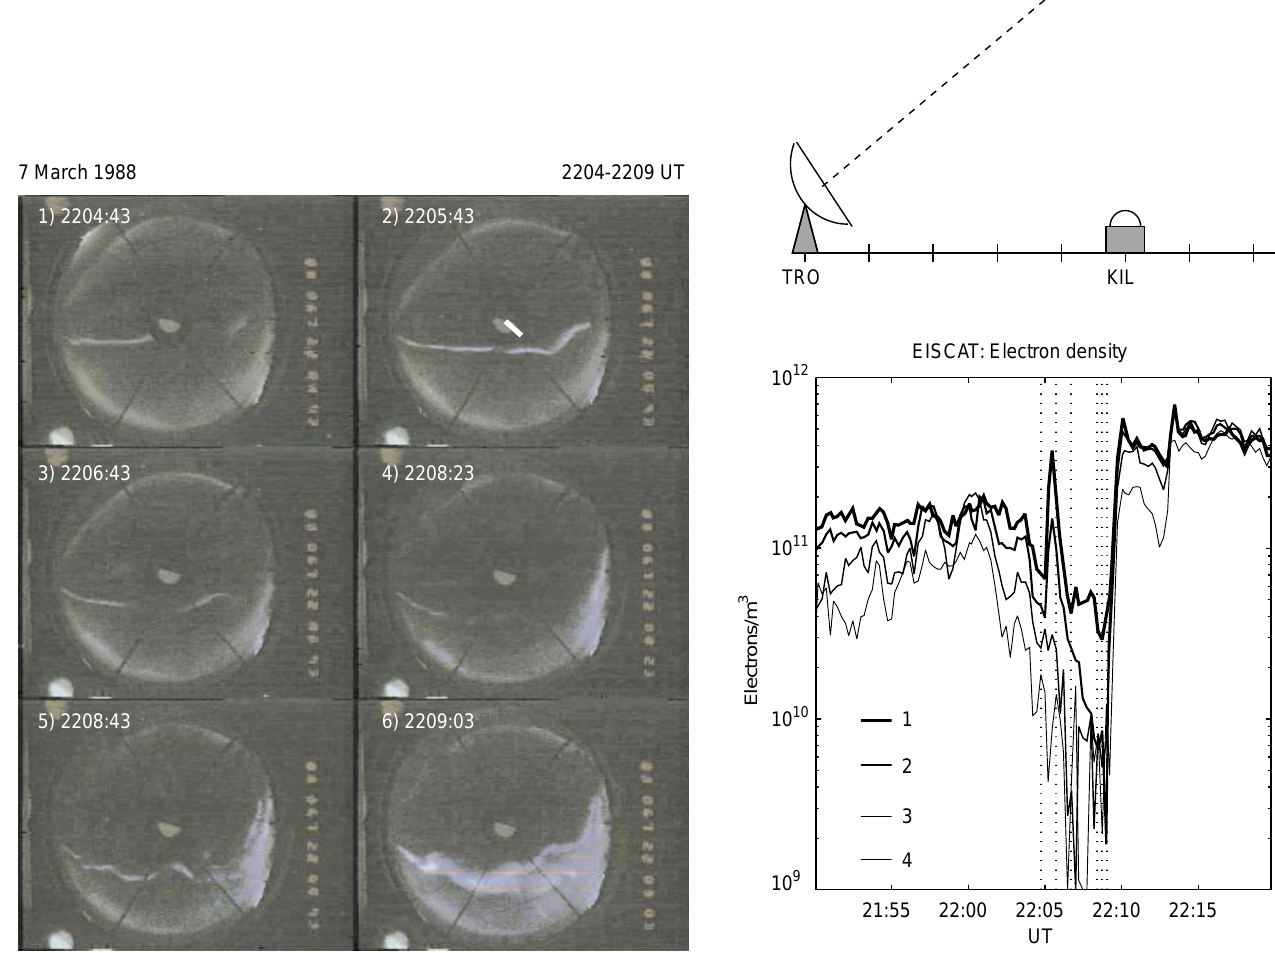
lower right panel . The vertical dotted lines mark the times of the ASC frames. The approximate locations of the measuring points are shown with the white line in the ASC frame